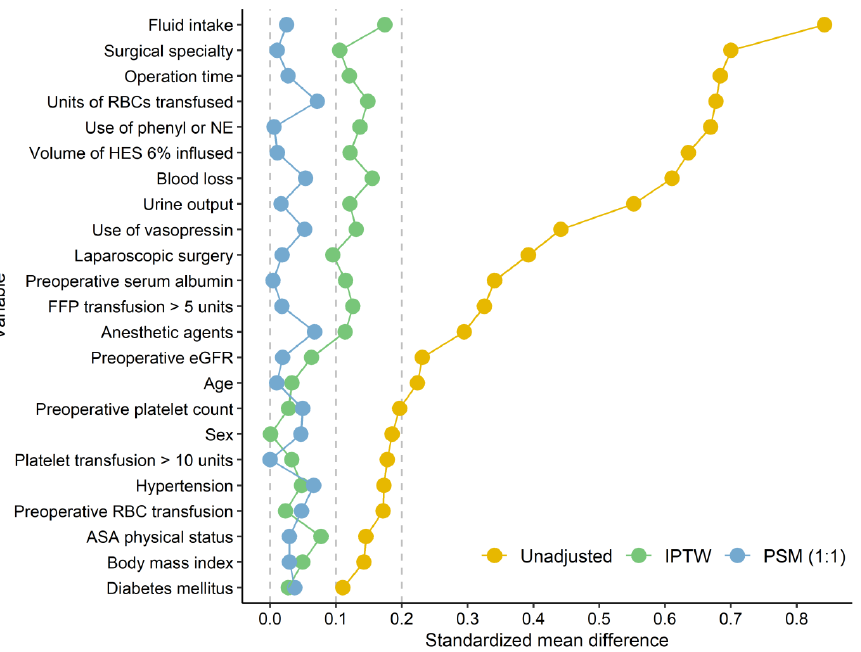
Figure 4. SMD of the preoperative and intraoperative covariates in the unadjusted and adjusted cohorts. SMD, standardized mean difference; IPTW, inverse probability of treatment weighting; PSM, propensity score matching; RBC, red blood cell; phenyl, phenylephrine; NE, norepinephrine; HES, hydroxyethyl starch; FFP, fresh frozen plasma; eGFR, estimated glomerular filtration rate; ASA, American Society of Anesthesiologists.